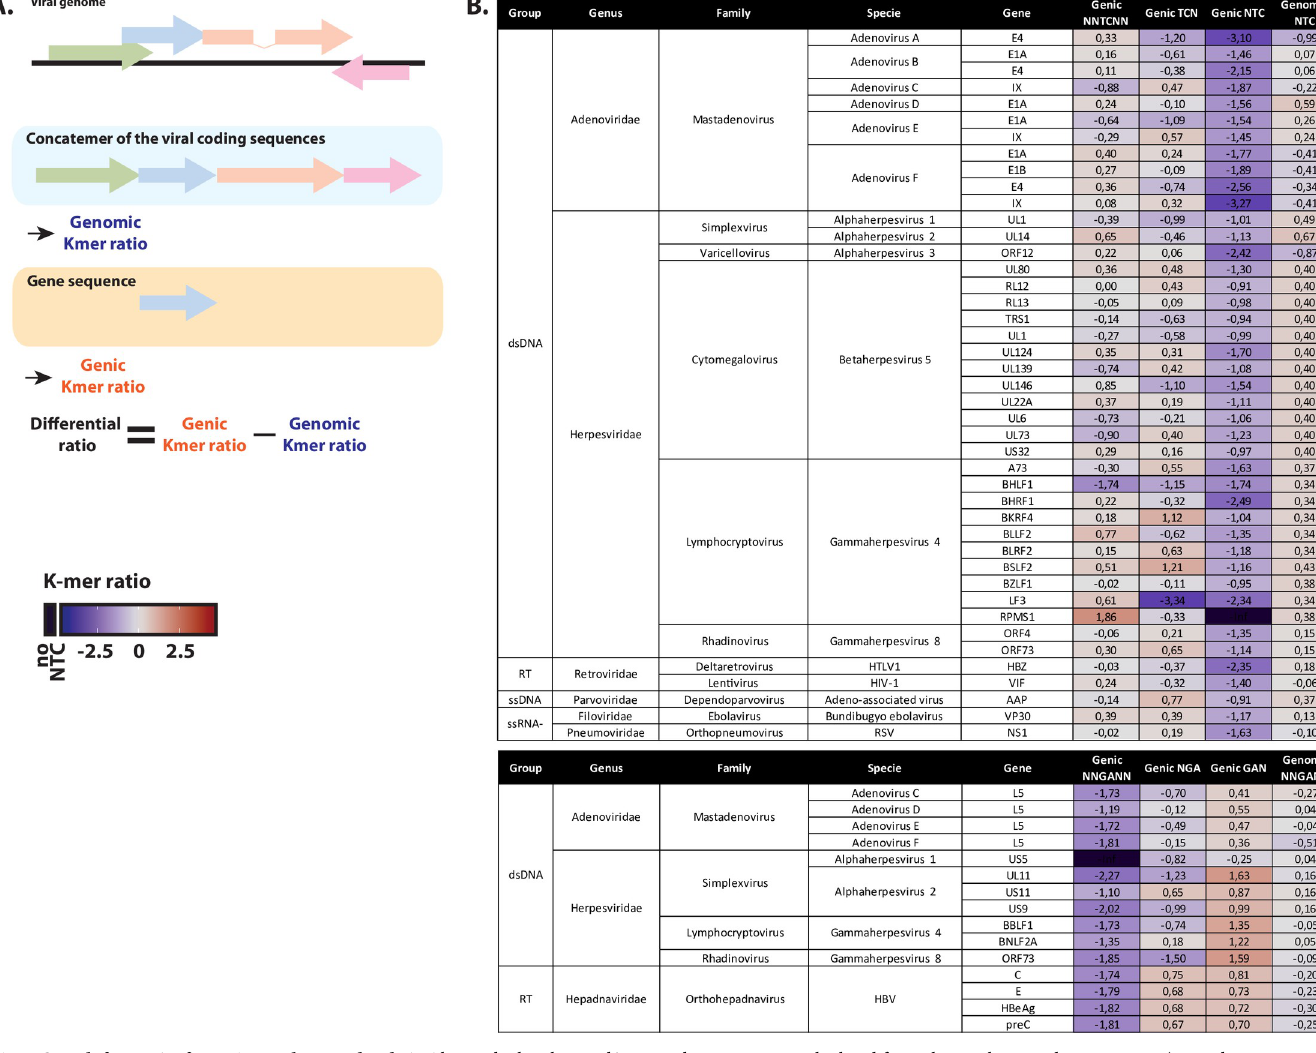
Fig 7. Search for an A3 footprint at the gene level. A. Alongside the observed/expected K-mer ratios calculated from the synthetic coding genomes (named genomic K- mer ratios), K-mer ratios were also computed for each viral coding sequence individually (named genic K-mer ratios). Differential ratio is defined as the subtraction of genic K-mer ratio to the corresponding genomic K-mer ratio. B. List of the putative A3-footprinted viral genes and belonging to an otherwise non-depleted viral genome (having at least five reported